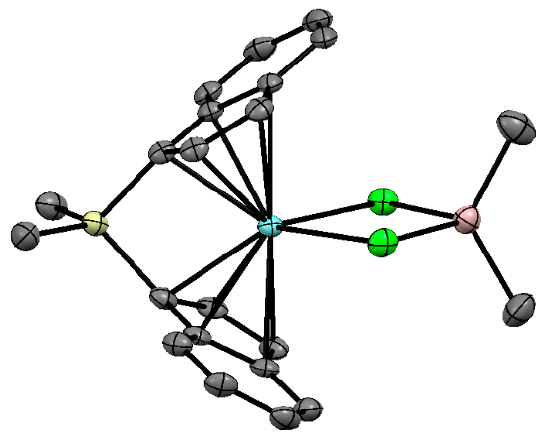
Figure 18. Molecular structure of rac -[Me 2 Si( η 5 -C 9 H 6 ) 2 ]Zr( μ -Cl) 2 AlMe 2 ( Zr22 ). Reprinted with permission from [164]. Copyright (2013) American Chemical Society.